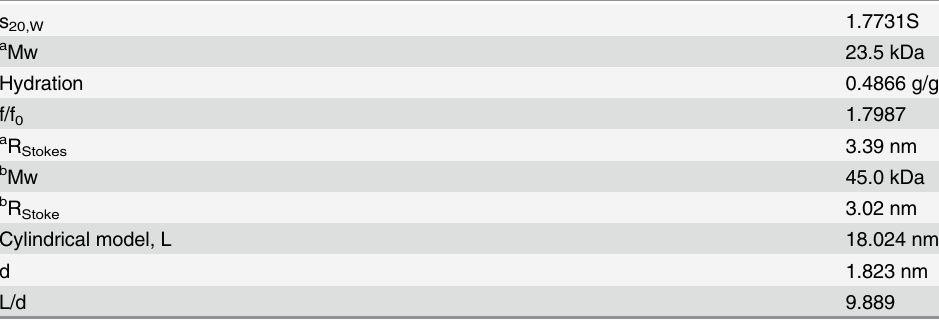
a The apparent molecular weight (Mw) and Stokes ’ radius (R Stokes ) of HMGA2 was calculated according to sedimentation velocity studies. fi ltration results. In this table, b The apparent Mw and R Stokes of HMGA2 were calculated according to gel- we assume that HMGA2 is a cylinder. Two parameters, L, the length of the cylinder and d, the diameter, are required to calculate the hydrodynamic model. The following three equations are used to compute L ; f ¼ and d: s ¼ M ð 1 (cid:2) nr Þ N 0 f molecular weight of the solute (protein), the sedimentation coef fi cient, the friction coef fi cient, the partials